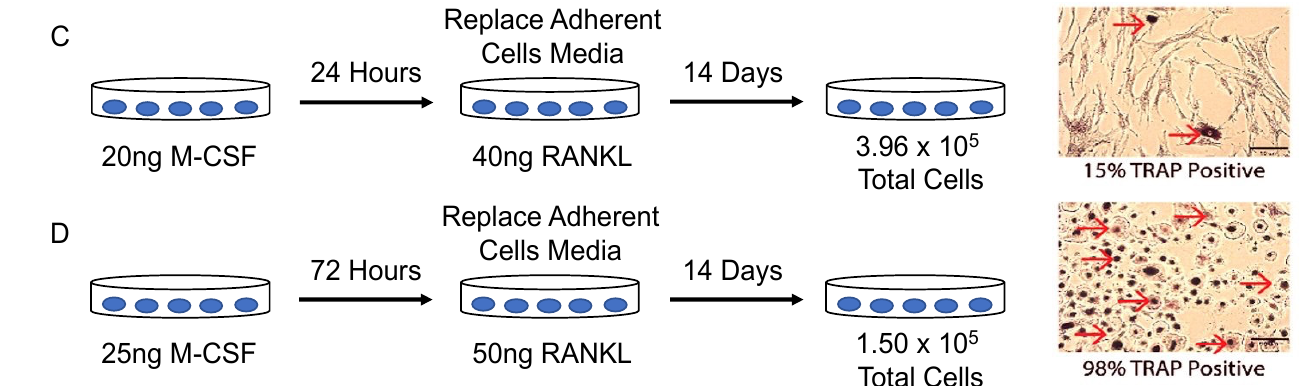
Figure 4. Cells extracted from human femoral heads were plated with different conditions and were stained for TRAP. ( A ) Cells were plated with 10 ng/mL M-CSF for 24 h. Non-adherent cells were